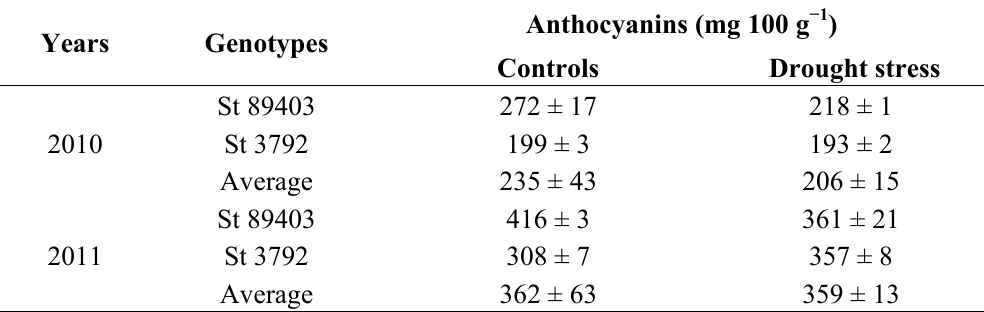
Table 3. Total amounts of anthocyanins in lyophilized tissue samples prepared from control and drought stressed tubers grown in 2010 and 2011 (Mean ± SD; n =